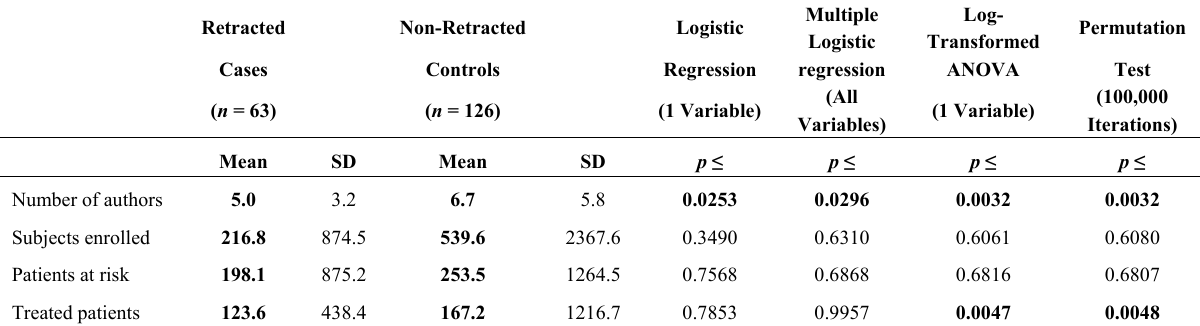
Table 1. Comparison of retracted randomized clinical trials (RCTs) (cases) and non-retracted RCTs (controls). “Logistic Regression” predicts retraction from all four predictors one-at-a-time and is significant only for the number of authors. All other analyses do not use a block structure, since this added nothing to the overall predictive ability of the model. “Multiple Logistic Regression” tries to predict retraction from all four predictors in a single equation; the small disagreement between this analysis and the logistic regression suggests that there is some correlation among predictors, such that when all predictors are used together, each adds a small increment to the overall prediction. The log-transformed analysis-of-variance (Log-Transformed ANOVA) uses log-transformed predictors to address likely skew in the data. The “Permutation Test” is used to test the same hypotheses as the ANOVAs, but permutation tests make fewer assumptions. As expected, p -values are nearly identical to the ANOVA, indicating that the assumptions of the ANOVA are met. These p -values were not corrected for multiple comparisons, because they demonstrate only a mild association that was not useful for prediction. All analyses, except the multiple logistic regression, were sensitivity analyses. Had we corrected p -values in the multiple logistic regression, they would not have achieved statistical